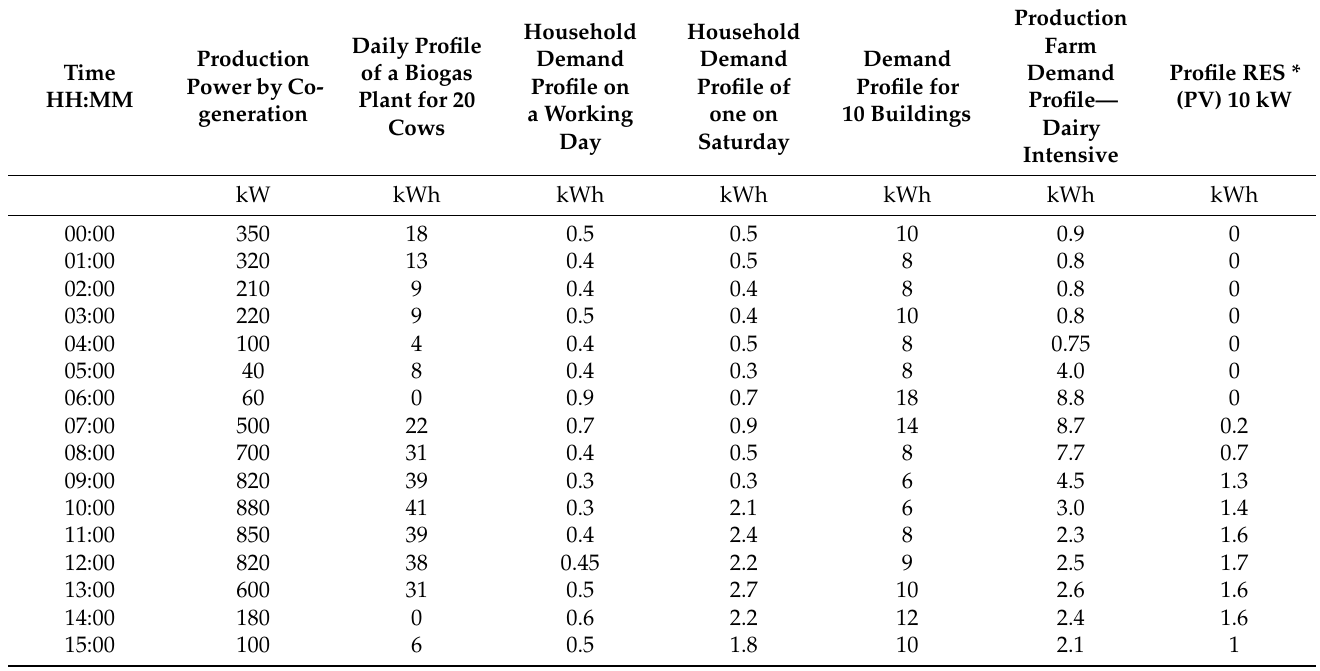
Table 4. Daily electricity and electricity demand.